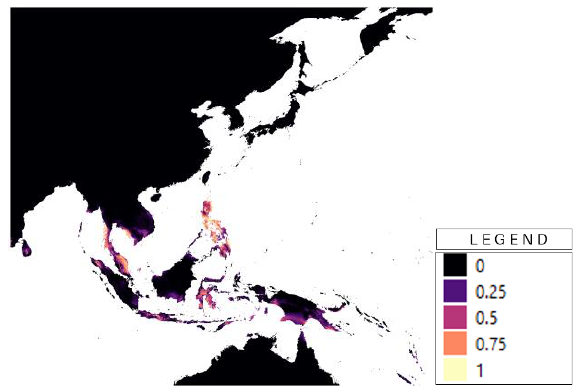
Figure 6. Visualized prediction within the Philippines’ vicinity for C. manillensis